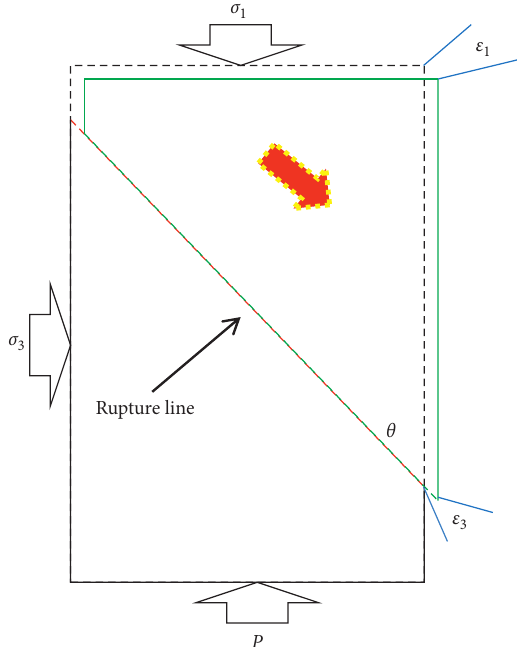
Figure 14: Schematic diagram of typical rock failure under triaxial compression.